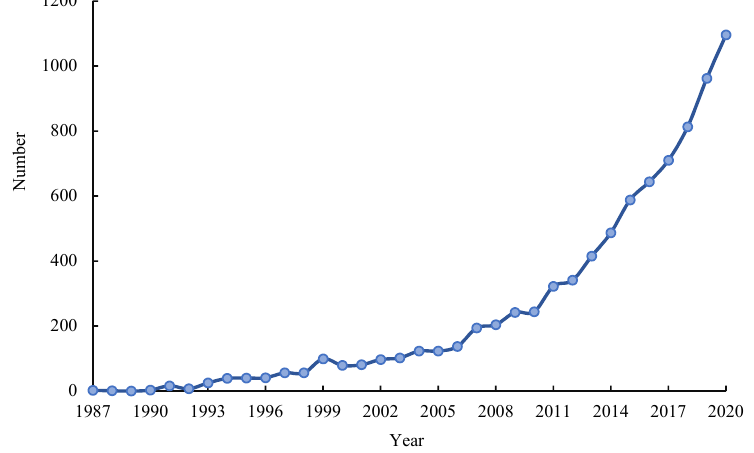
Figure 1. Number of literatures concerning LUT research from 1987 to 2020. According to data from Web of Science, by the end of 2020, the top three countries with the number of publications on LUT research are USA (2982), China (1496) and Germany (844), followed by UK, Australia, Canada, Netherlands, France, Spain and Italy (Table 1). Research on LUT has attracted widespread attention in various fields. Statistical analysis shows that research results related to LUT have been published in more than 1600 SCI/SSCI indexed journals, covering multiple disciplines and fields such as geography, environmental science, ecology, sociology, economics and urban planning. The top 10 journals with publication volume are: Land Use Policy, Sustainability, Remote Sensing of Environment, Re- mote Sensing, Science of the Total Environment, Land, Plos One, Applied Geography, Landscape and Urban Planning and Environmental Research Letters (Figure